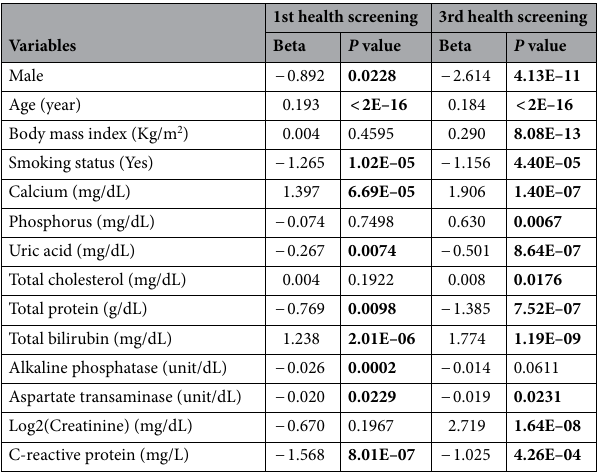
Table 3. Associations between clinical and serum parameters and FEV1% predicted value at the first and third health screenings. Bolds represent significant results ( P < 0.05).